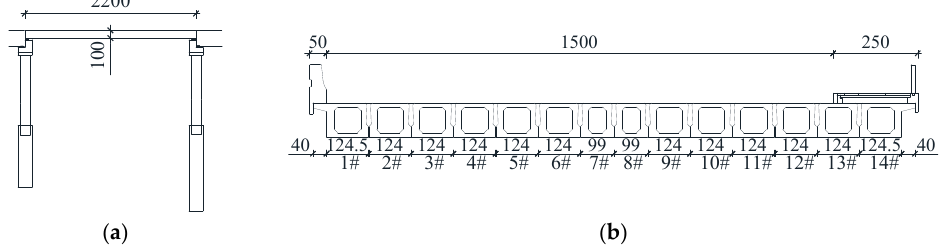
Figure 10. Detailed geometrical parameters of the actual beam bridge (units: cm): ( a ) vertical view and ( b ) cross-sectional view.